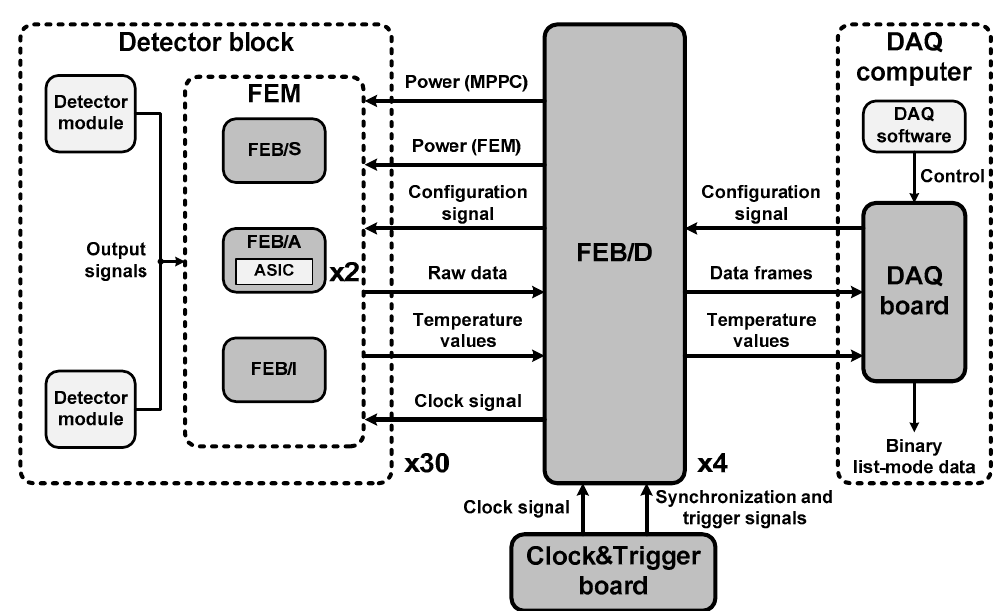
Figure 3. Block diagram of the individual channel readout electronics for the developed TOF brain PET.